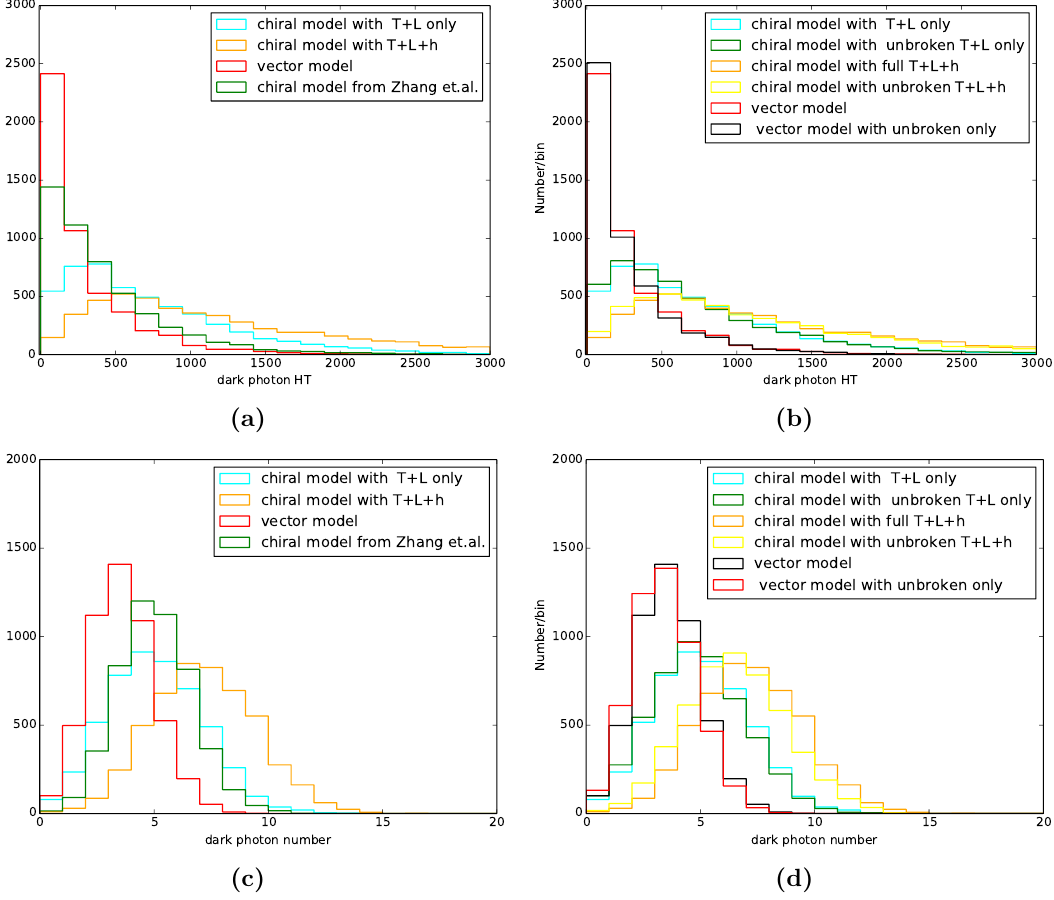
Figure 4 . Same as (cid:12)gure 2 but with Point C: (cid:11) 0 = 0 : 075, m (cid:31) = 1 : 4 GeV, m A 0 = 0 : 4 GeV, and m h 0 = 1 : 4 GeV.